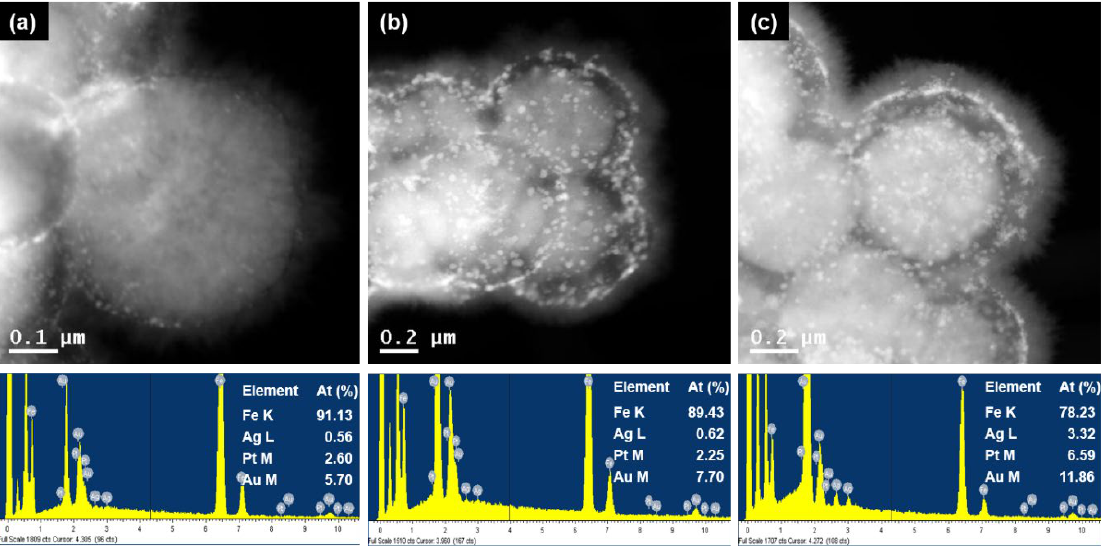
Figure 4. STEM images and the corresponding EDX data of MNP@PD x /Au-Ag-Pt/IO, where x is ( a ) 30, ( b ) 60 and ( c ) 100. ( a ) 30, ( b ) 60 and ( c )